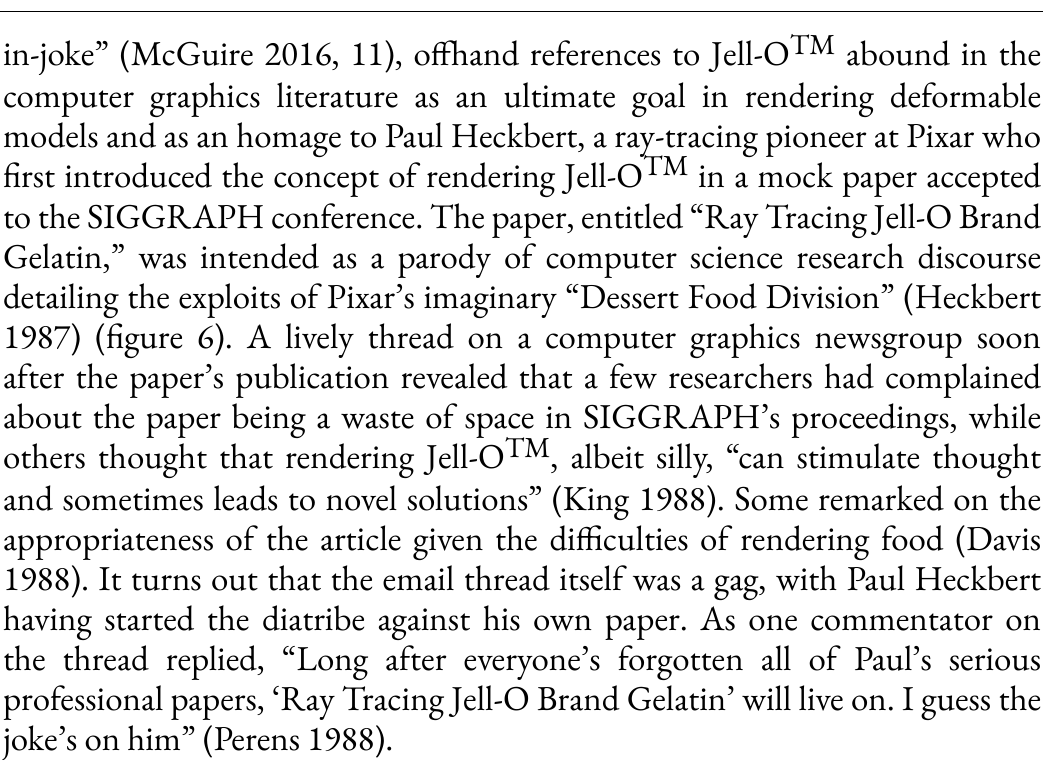
Figure 6: A rendering of lime Jell-O TM (Heckbert 1987). Courtesy of Paul